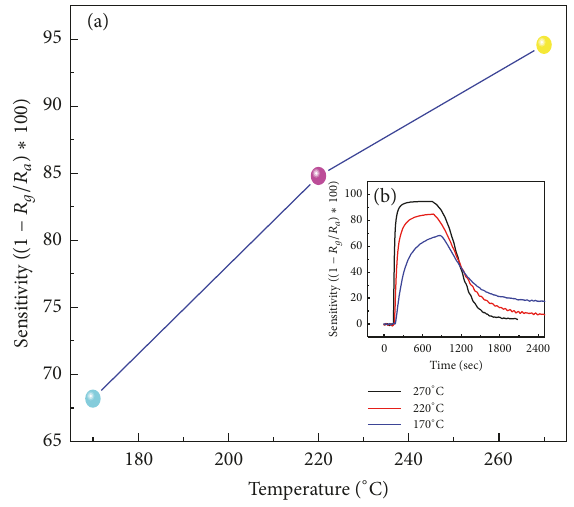
Figure6:(a)Sensitivityplotatdifferentoperationtemperatures170, 220, and 270 ∘ C. (b) Dynamic responses from the sensor fabricated using Fe doped TiO 2 sample under the exposure of 500ppm H 2